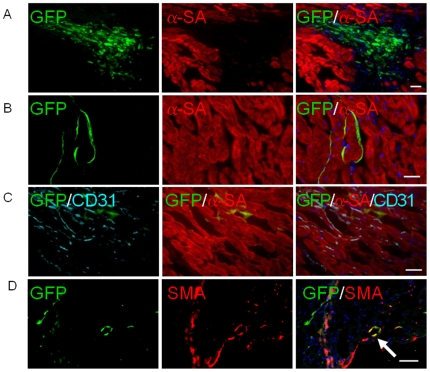
Confirmation of engrafted hESC-ECs by immunofluorescence.(A) Fate of hESC-ECs within the recipient myocardium 4 days after injection showed clump formation. (B, C, D) At day 28, transplanted hESC-ECs differentiate into vasculature and smooth muscle cells (arrow), and integrate with host myocardium as confirmed by GFP, mouse CD31, α-sarcomeric actin (α-SA) and smooth muscle actin (SMA) co-staining. However, this population became significantly rare compared to day 4 due to donor cell death. Scale bar = 20 µm.